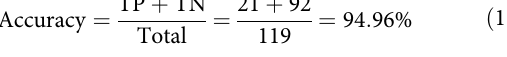
(magenta) and not voltage-gated (black) events. The dotted